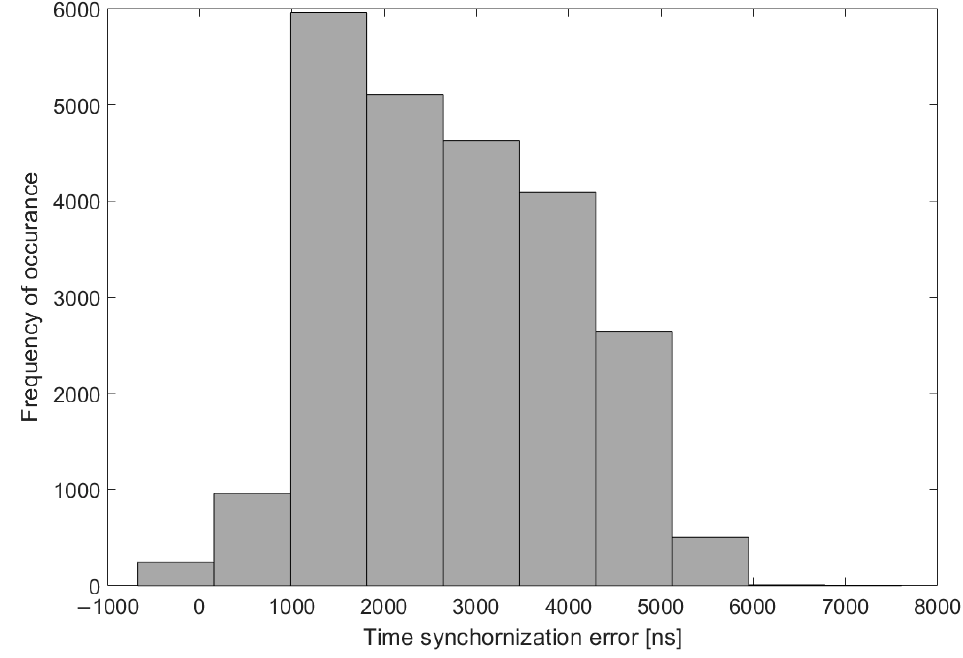
Figure 11. Time synchronization error measurements of 5G integrated with TSN.